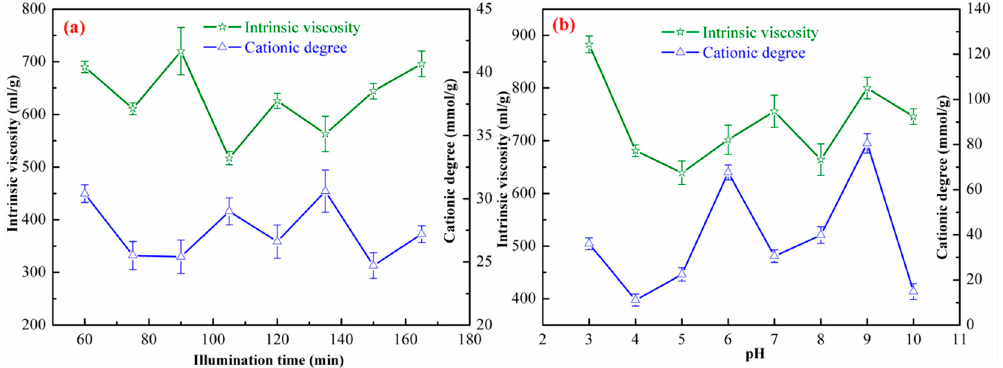
Figure 2. Effect of ( a ) illumination time and ( b ) pH on polymerization.